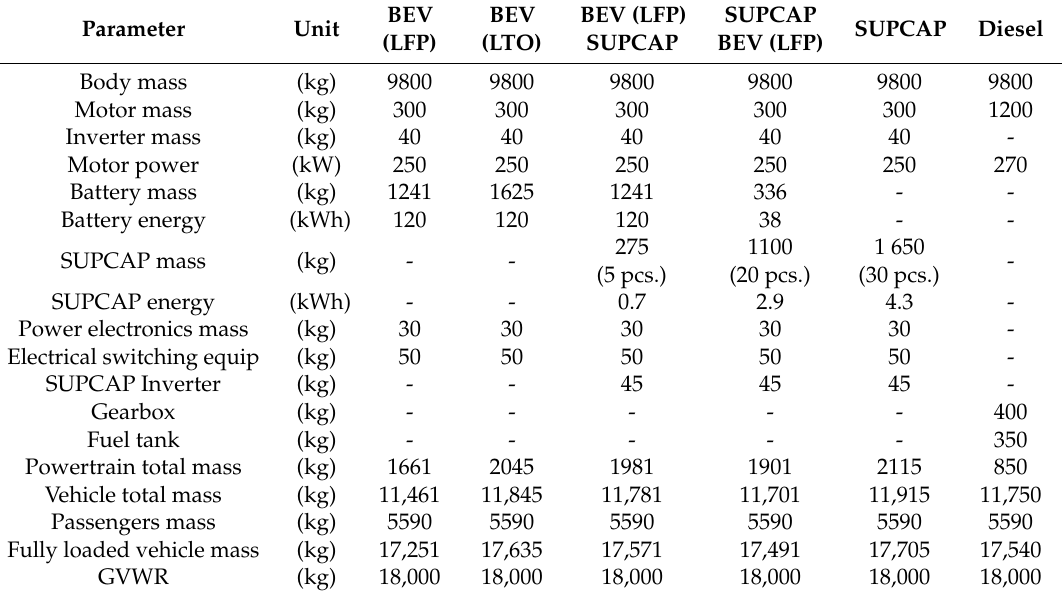
Table 1. Parameters of components used in the drive systems shown in Figure 1.